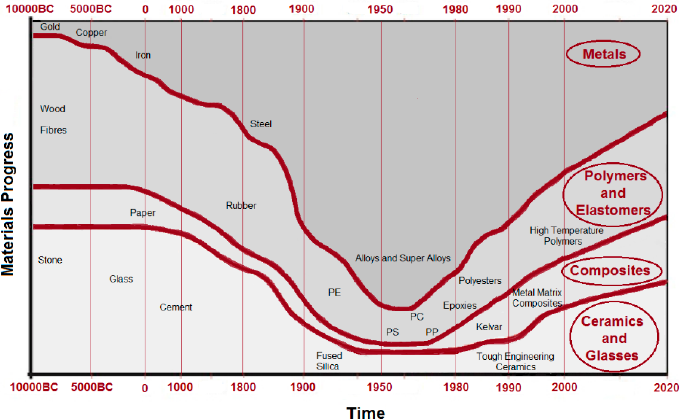
Figure 2. Evolution of the engineering materials (Redraw and adapted figure from [8]).